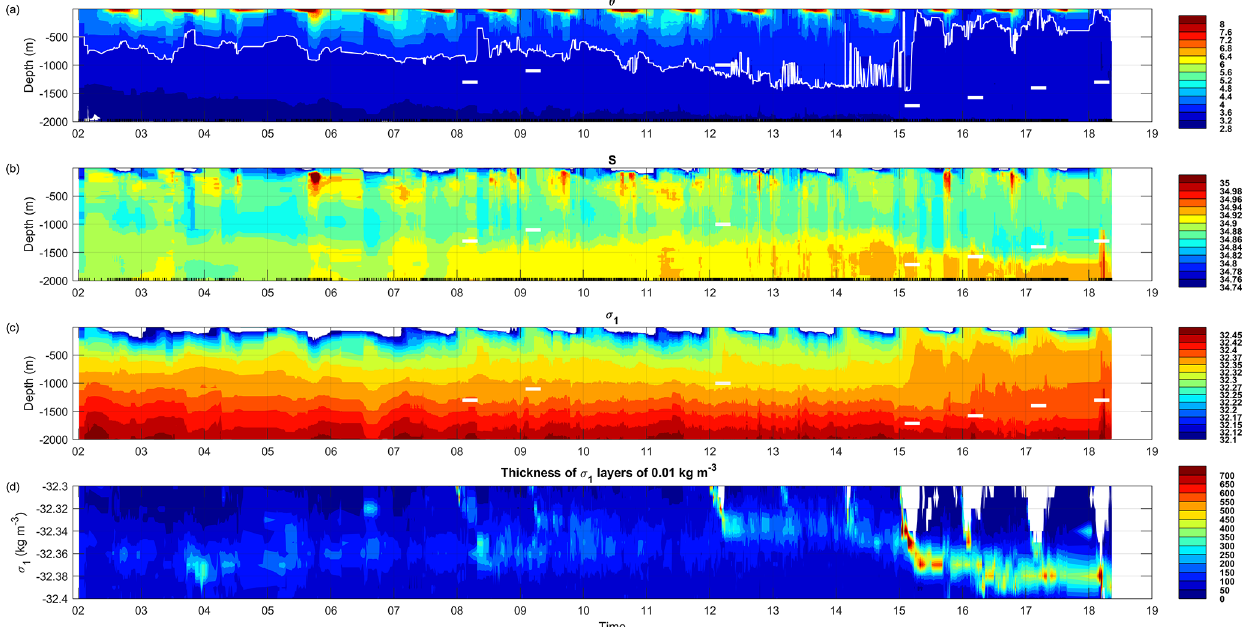
Figure 5. Time evolutions of vertical profiles measured from Argo floats in the SECF region: (a) θ , (b) S , (c) σ 1 and (d) the thickness of 0.01kgm − 3 thick σ 1 layers. The white horizontal bars in plots (a) , (b) and (c) indicate the maximal convection depth observed in the Irminger Sea or SECF when deep convection occurred. The white line in plot (a) indicates the depth of the isotherm 3.6 ◦ C. The black vertical ticks on the x axes of plot (b) indicate times of Argo measurements. These figures were created from all Argo profiles reaching deeper than 1000m in the SECF region (56.5–59.3 ◦ N, 45–38 ◦ W; pink box in Fig. 1). The yearly numbers of Argo profiles used in this figure are shown in Fig.